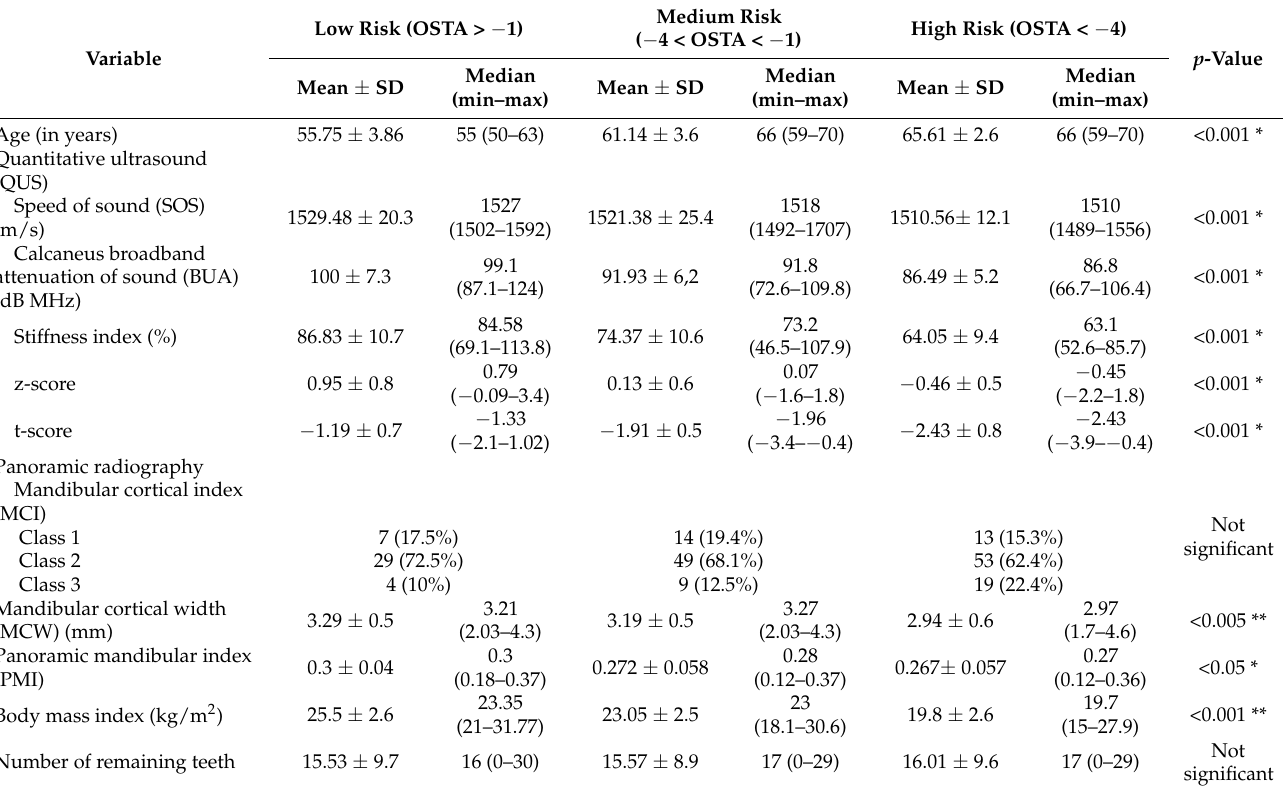
Table 3. The relationship of the Osteoporosis Self-Assessment Tool for Asians (OSTA) with all of the variables in women.